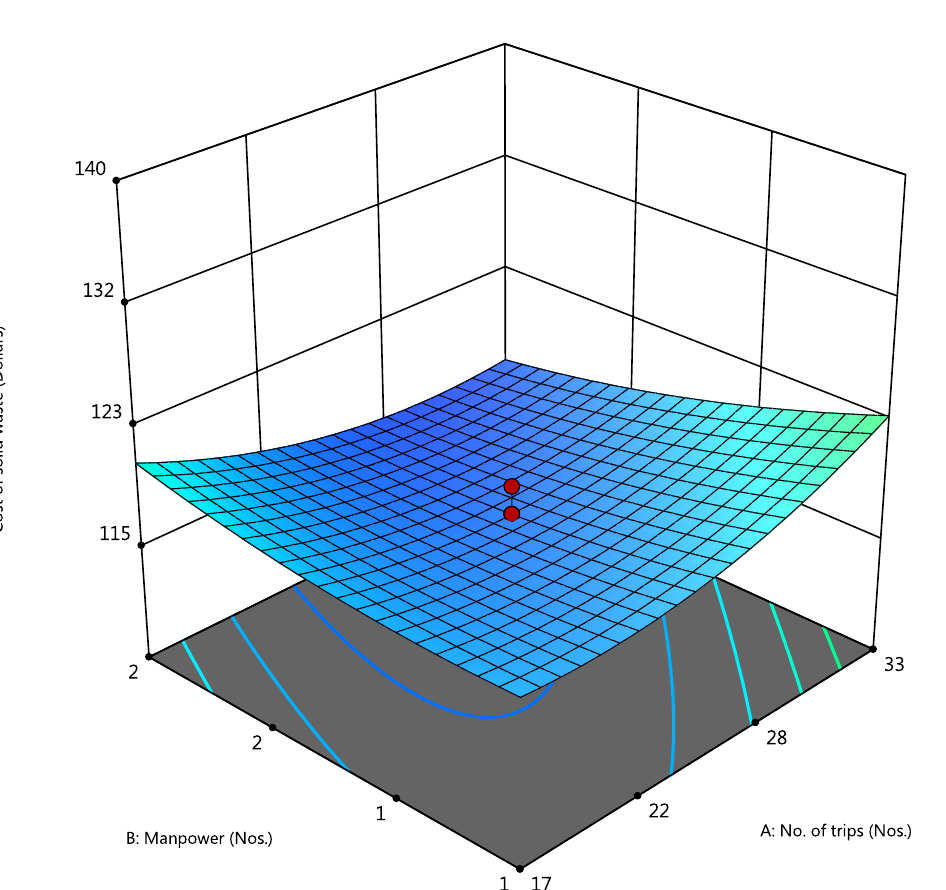
Figure 3. 3D surface plots showing the dependency of the number of workers and number of collection trips on the cost of a solid waste management system (Design-Expert software v.